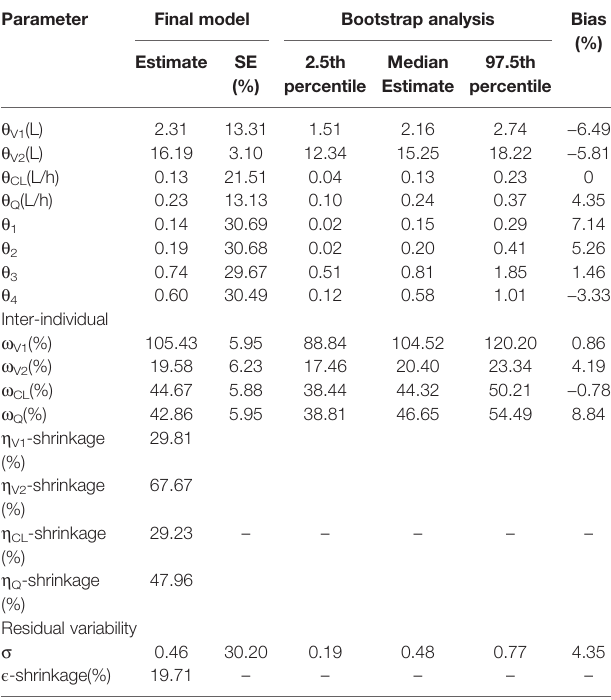
TABLE 4 | Parameter estimates and bootstrap results of the fi nal model. Parameter Final